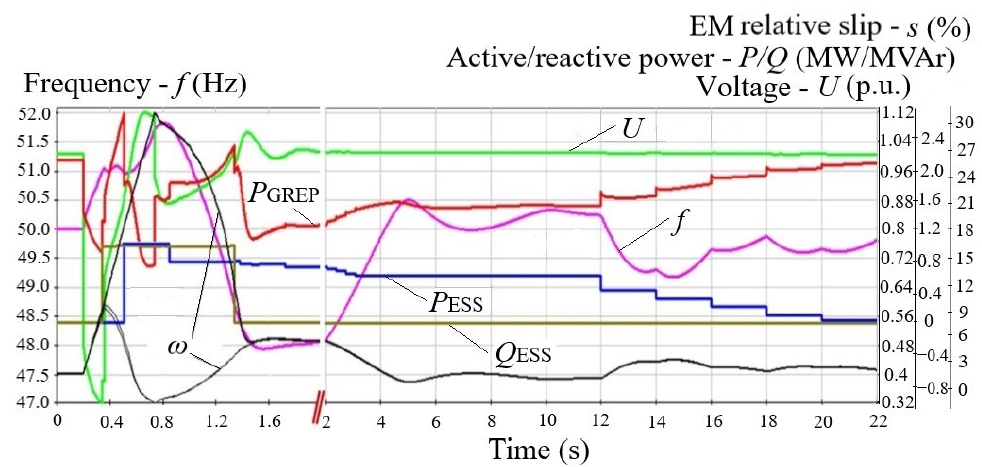
Figure 6. Transient at three-phase short-circuit in the power supply system with GREPs.